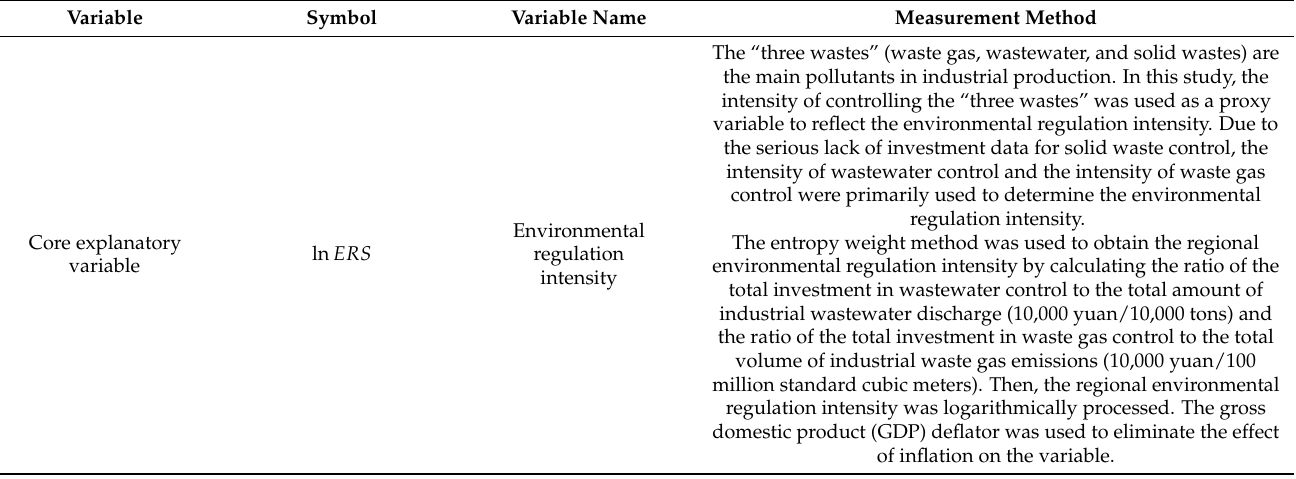
Table 3. Indices and calculation